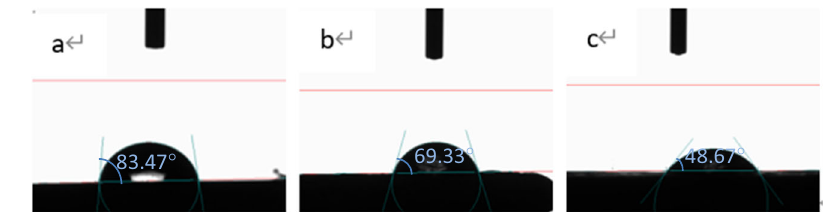
Fig. 5 Contact angles of different material surfaces ( a ) PEEK; ( b ) SPEEK; ( c ) SPEEK- GO. The CA values of PEEK, SPEEK, and SPEEK-GO were 83.47 ± 0.15°, 69.33 ± 2.52°, 48.67 ± 1.53°,